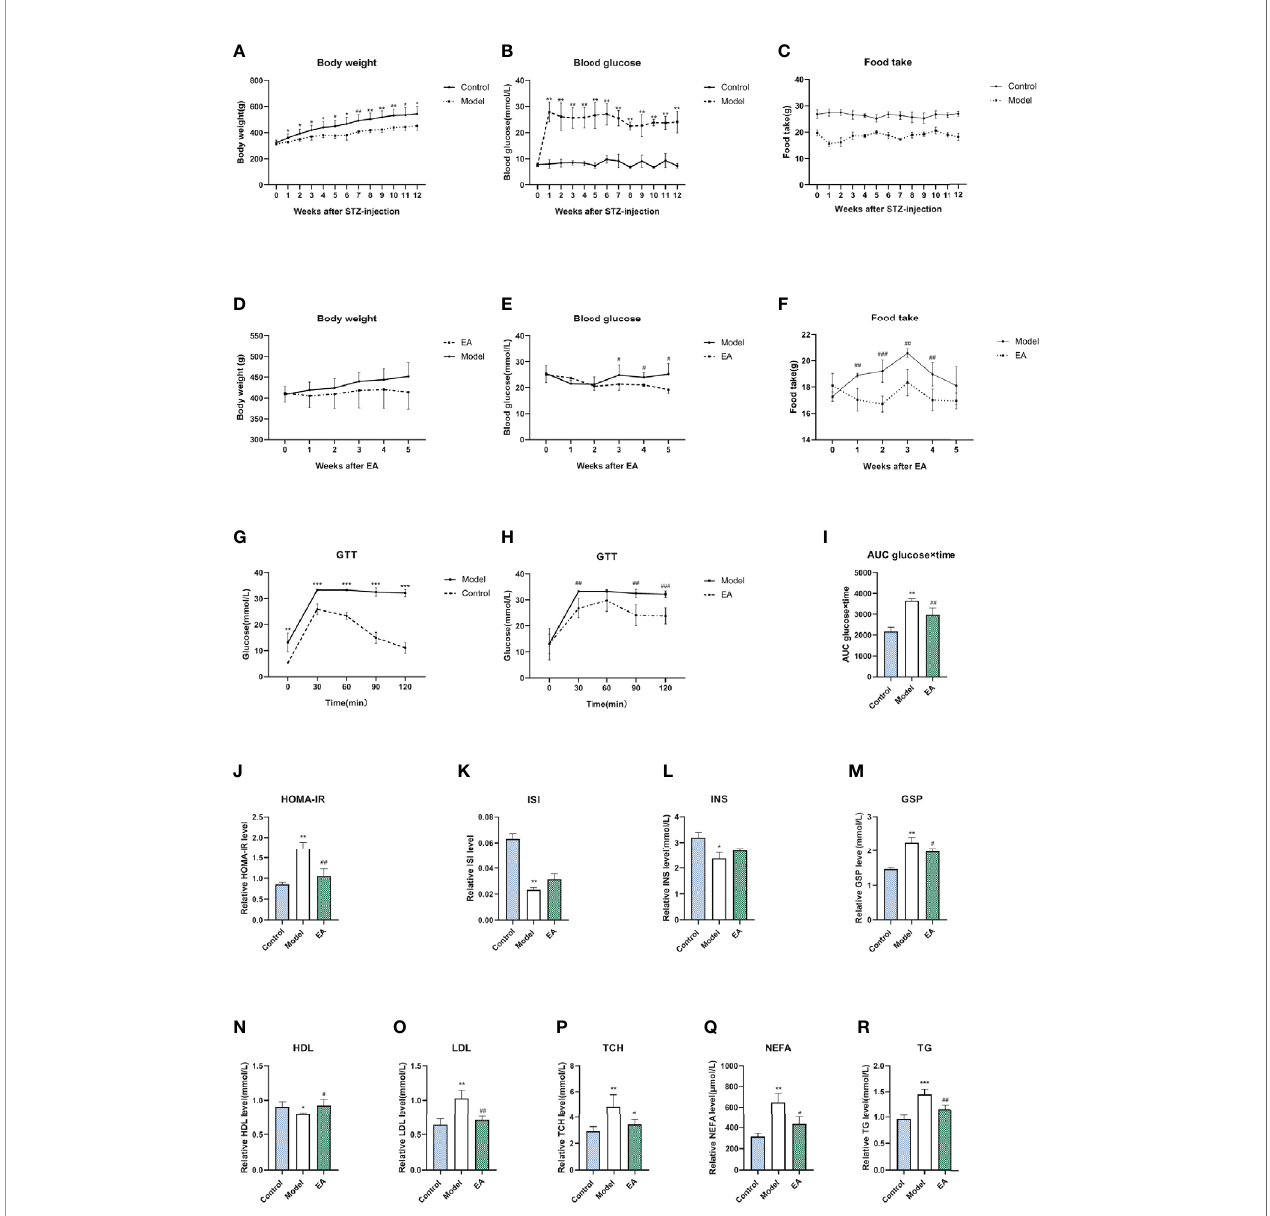
FIGURE 1 | Metabolism index of HFD-STZ rats in different groups. Levels of body weight (A) , blood glucose (B) , food intake (C) , and glucose tolerance test (GTT) (G) in the control group and model group over 12 weeks (n = 6, *p < 0.05, **p < 0.01, ***p < 0.001). The signi fi cance was not marked in the fi gure since the food was not the same. Compared to the model group, EA treatment decreased body weight (D) , blood glucose (E) , food intake (F) , as well as hyperglycemia in GTT (H) and related AUC levels (I) signi fi cantly (n = 6, # P < 0.05, ## P < 0.01, ### P < 0.001). Levels of homeostasis model assessment for insulin resistance (J) , insulin sensitivity index level (K) , fasting insulin level (L) , glycosylated serum protein level (M) , high density lipoprotein level (N) , low density lipoprotein level (O) , total cholesterol level (P) , non-esteri fi ed fatty acid (Q) , and triglycerides level (R) in serum of rats after saline, HFD-STZ-induced, and EA treatment (n = 4, *p < 0.05, **p < 0.01, ***p < 0.001, # p < 0.05, ## p <